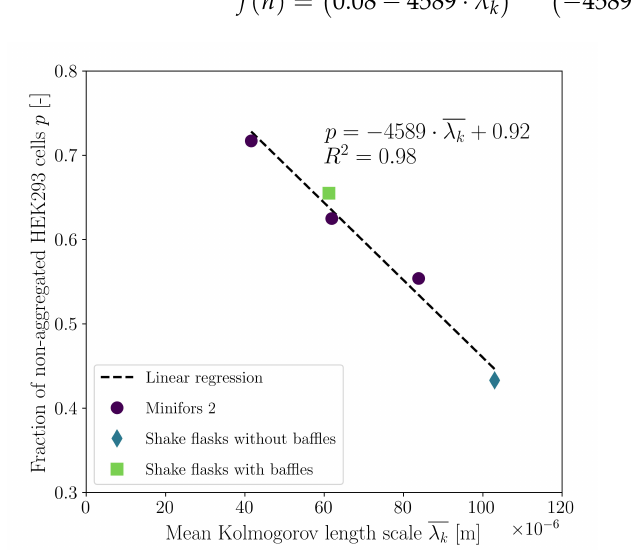
Figure 14. Dependence of the proportion of non-aggregated cells on the mean Kolmogorov length scale. The linear relationship applies independently of the investigated cultivation system and type of mechanical power input. The dependent parameter p can be used to predict the aggregate size distribution via the geometric distribution (Equation (19)) at the time of maximum